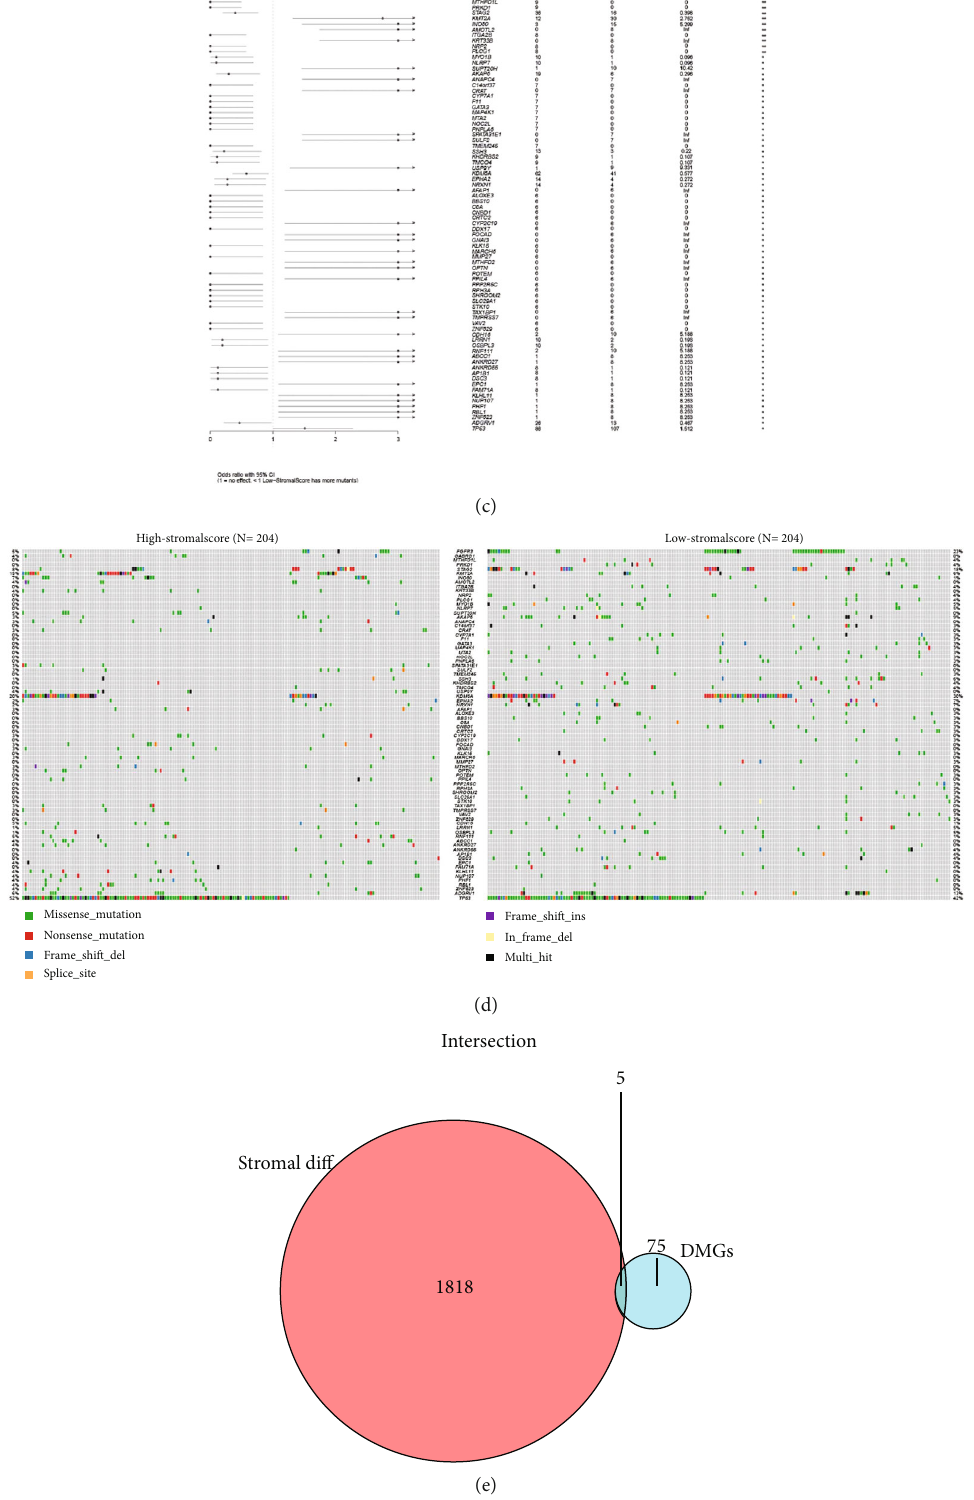
Figure 4: Analysis of somatic mutations between the two immunity groups and identi fi cation of common genes in DEGs and DMGs. (a, b) Waterfall plots showing the distribution of the top 30 most frequently mutated genes. (c) Forest plot showing signi fi cantly di ff erentially mutated genes between the two cohorts with ∗∗∗ p < 0 : 001 , ∗∗ p < 0 : 01 , and ∗ p < 0 : 05 . (d) Waterfall plot showing 80 DMGs between the high- and low-immunity groups. (e) Venn diagram showing the intersecting genes between DEGs and